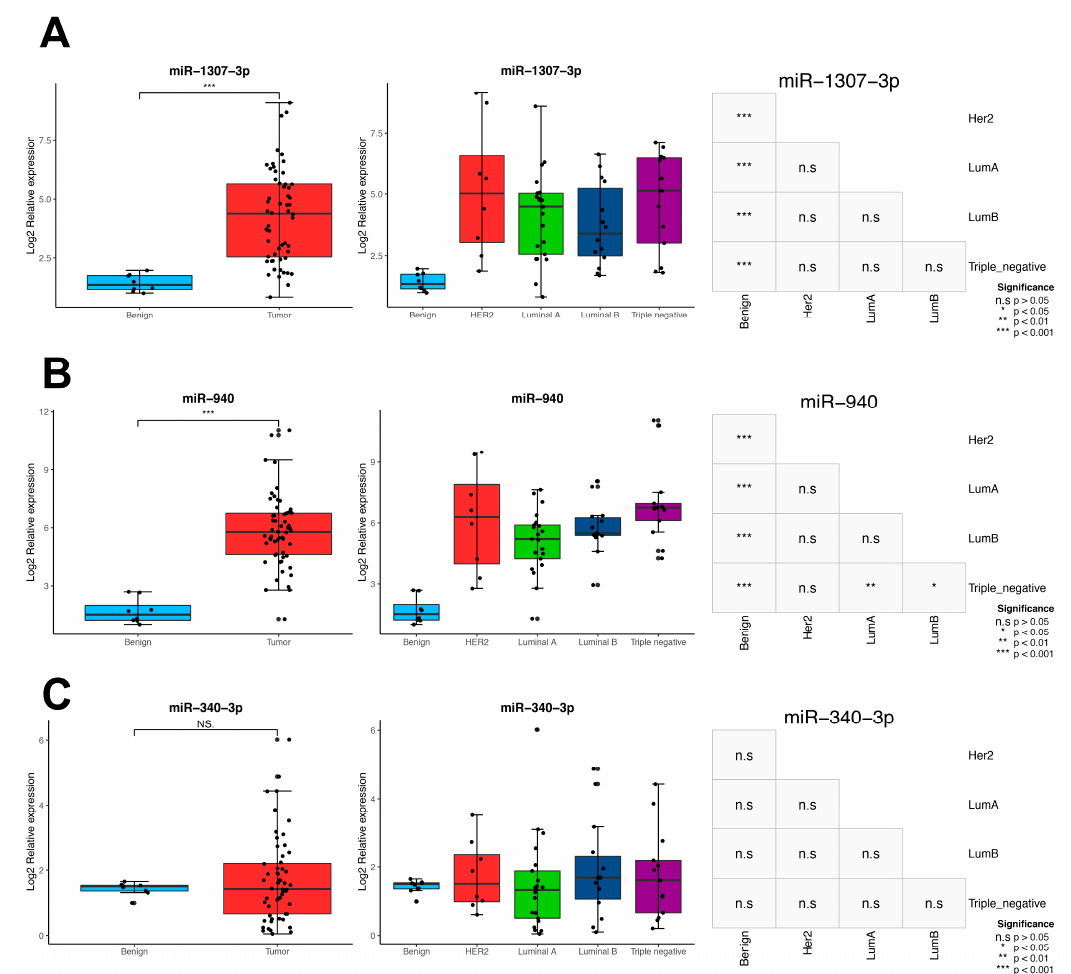
Figure 10. Validation in 56 locally advanced breast cancer samples using real-time qPCR. ( A ) Expression of miR-1307-3p in normal vs tumoral tissues and between the tumor subtypes. The boxplots represent the log2 relative expression and the heatmap shows the significance of the comparisons between each subtype, where the significance is annotated as * = p < 0.05, ** = p < 0.01, *** = p < 0.001 and n.s = p > 0.05. ( B ) Expression of miR-940 and ( C ) Expression of miR-340-3p.